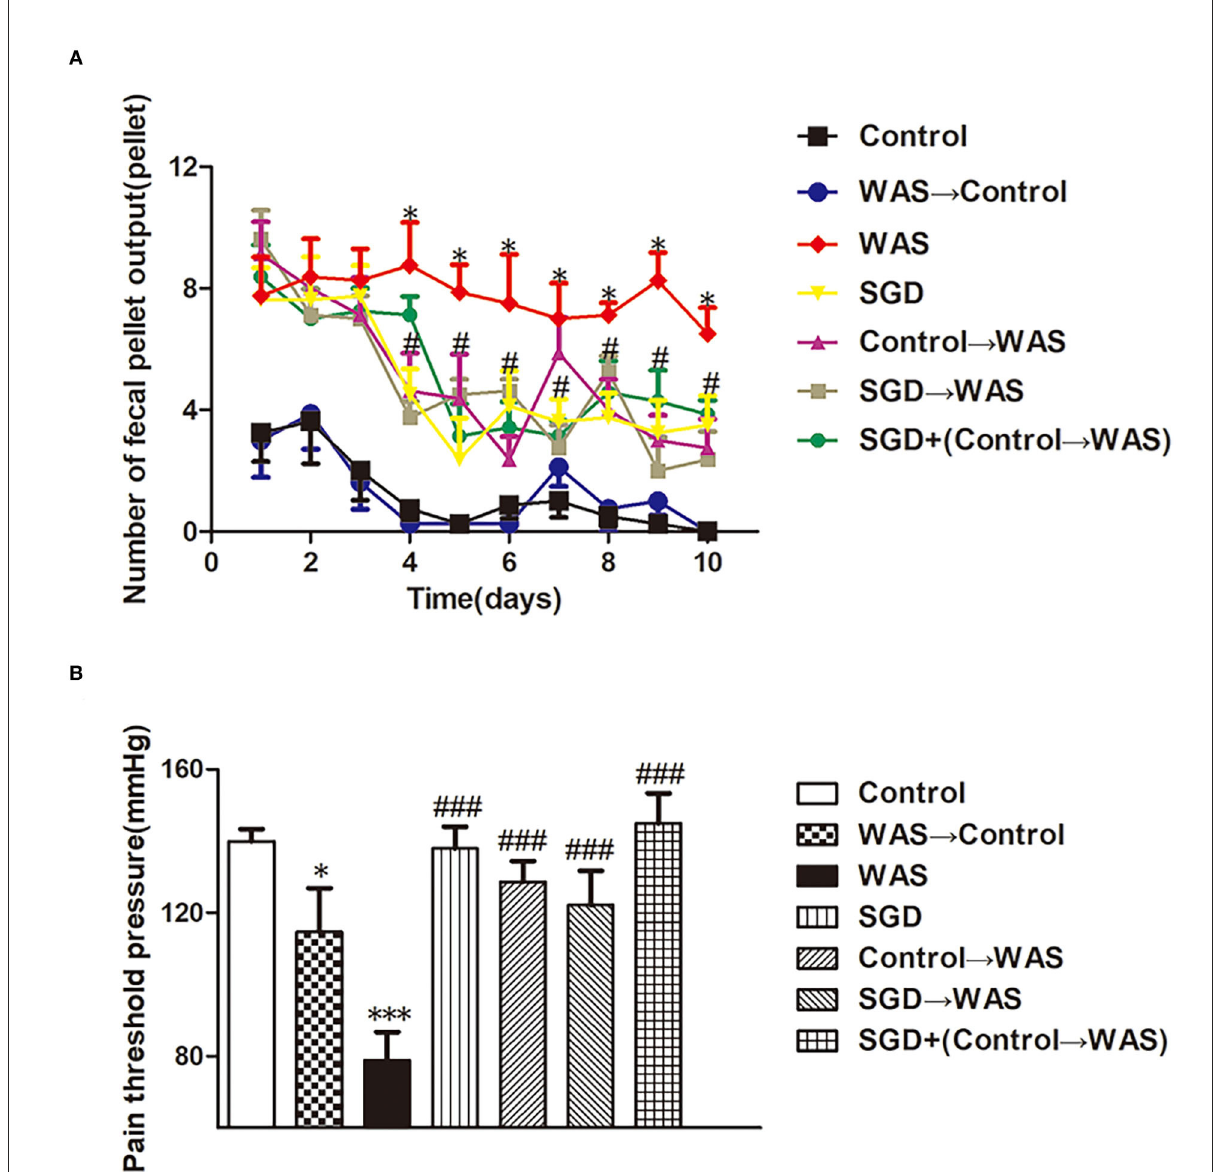
FIGURE3 Effects of several FMT combined with or without SGD on IBS-like symptoms of WAS rats. (A) Fecal pellet numbers output of rats every day. (B) PPT in rats (All results are expressed as mean ± SE n = 8/group, * P < 0.05 vs. Control, *** P < 0.001 vs. Control, # P < 0.05 vs. WAS, ### P < 0.001 vs.